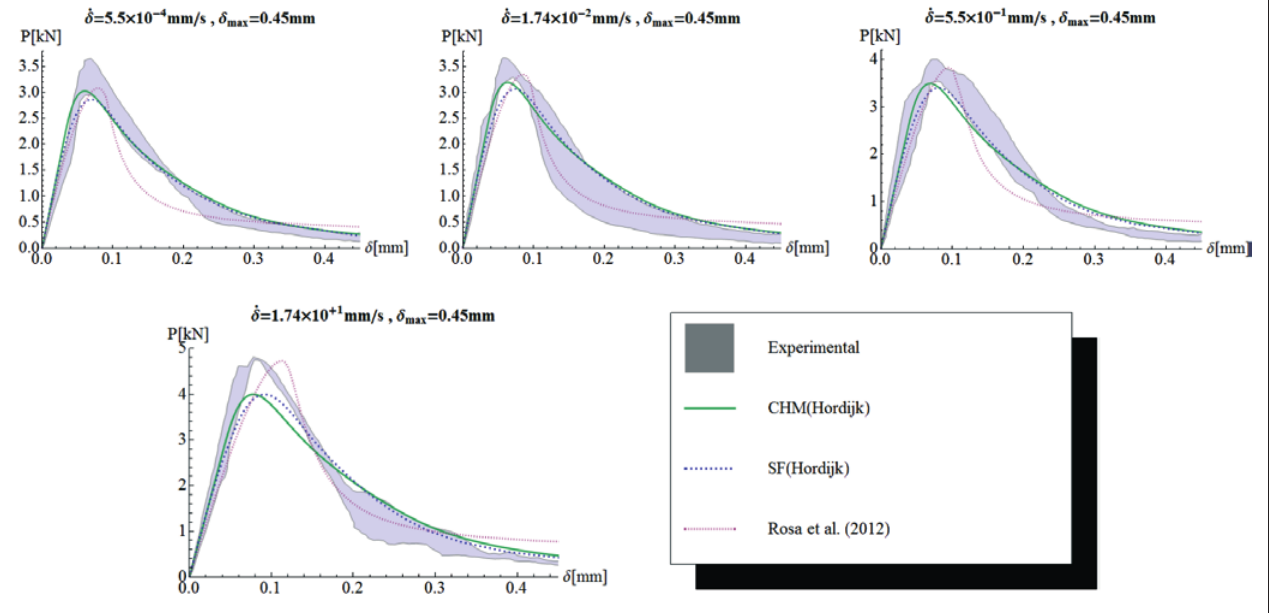
Figure 13 – Fit curve for the range of 0 to 0.45mm using Hordijk (1991) [33] curve set in section 5.3 P-